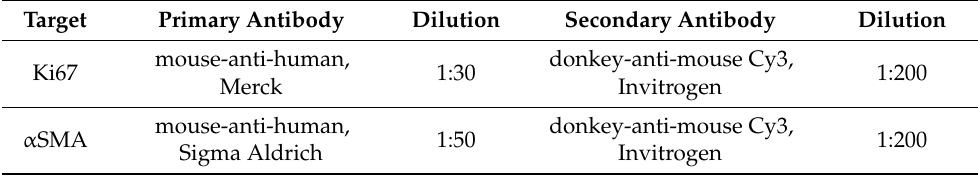
Table 1. Antibodies used for